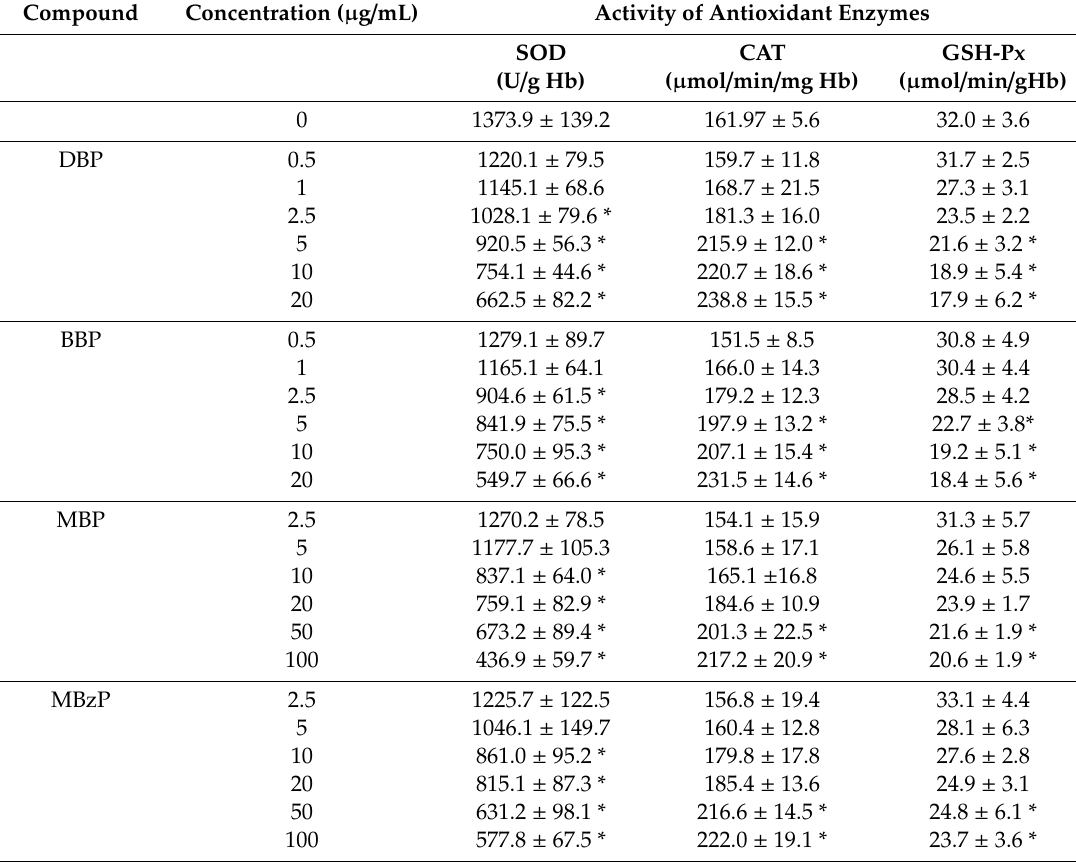
Table 2. Changes in the activity of SOD, CAT, and GSH-Px in control erythrocytes and in erythrocytes incubated for 24 h with DBP, BBP, MBP, and MBzP used at concentrations ranging from 0.5 to 100 µ g / mL.